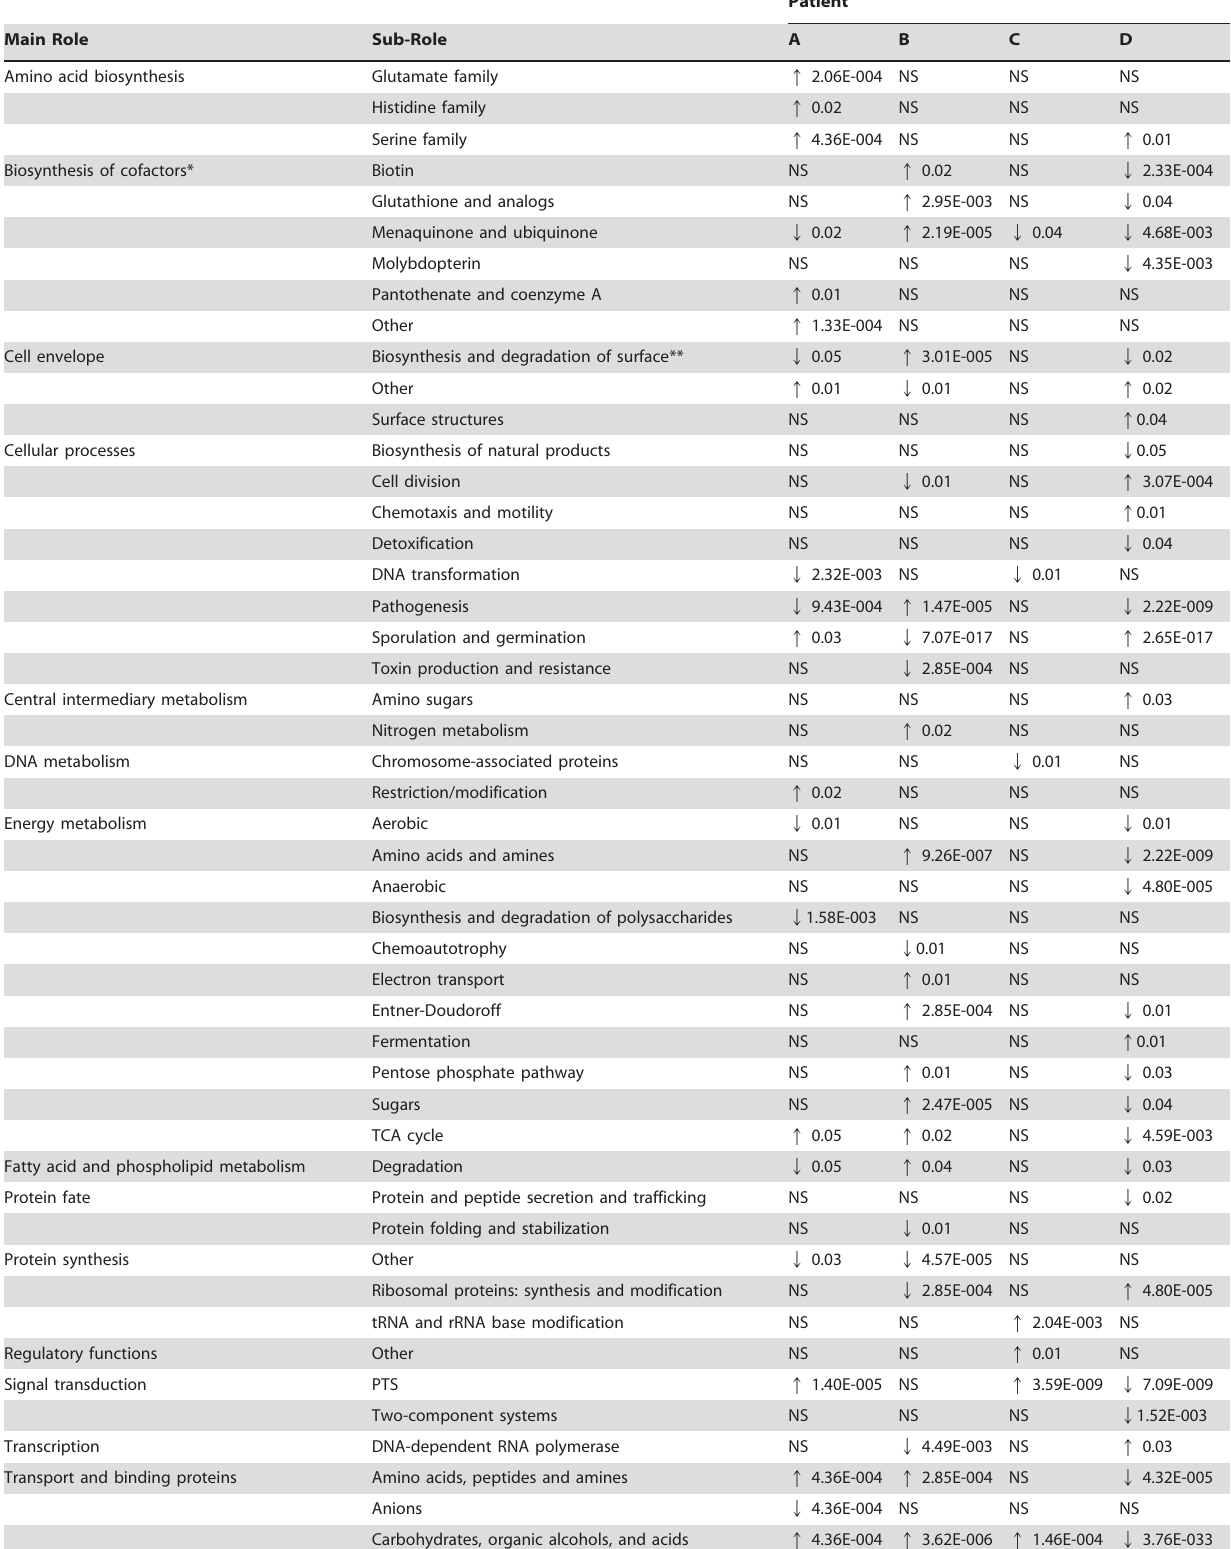
Table 2. Functional